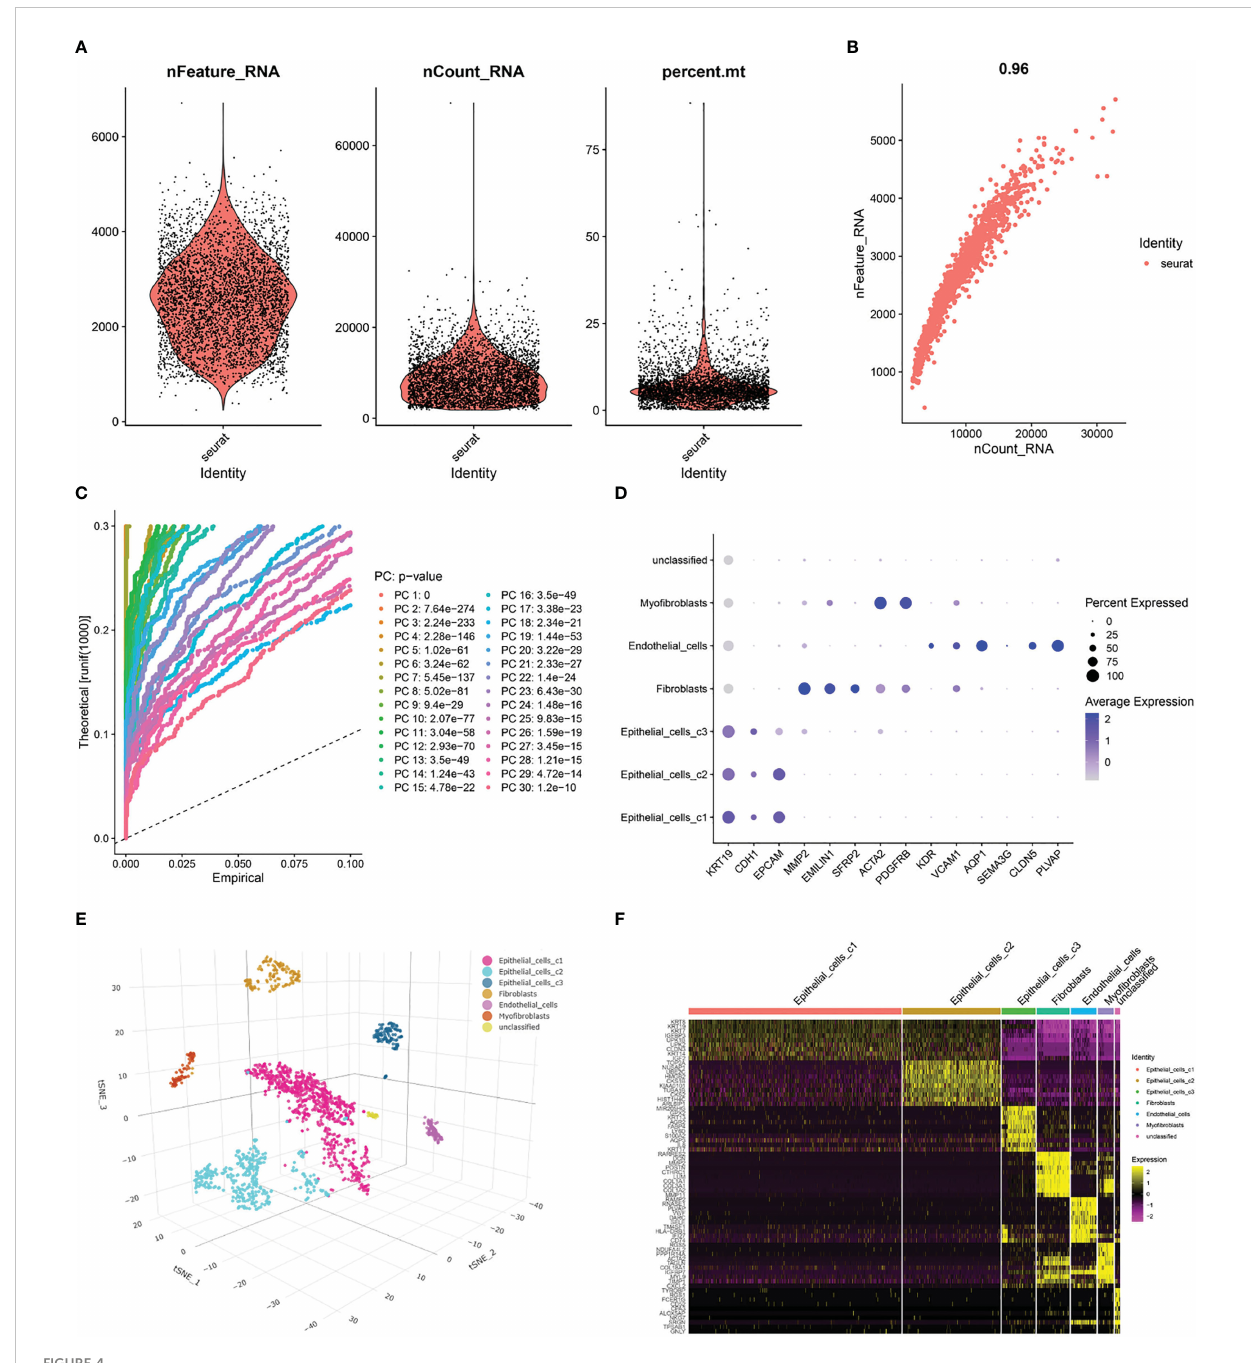
FIGURE 4 Processing of scRNA-seq data and acquisition of CAF marker genes. (A) Quality control of scRNA-seq data of BLCA cells. (B) Correlation between the number of genes and the depth of sequencing. (C) Principal component analysis (PCA) of the high-quality cells, and the top-30 PCs were displayed. (D) Dotplot of marker gene expression of each cell cluster. (E) T-SNE plot showing 7 clusters identi fi ed by integrated analysis, colored by cell cluster. (F) Heatmap of the marker genes with differential expression in each cell